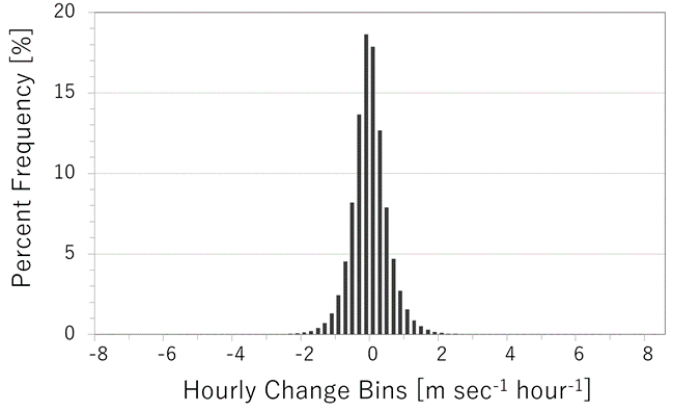
Figure 8. Percent frequency of the hourly changes in one-year 100-m onshore wind speed for all the horizontal grid points.